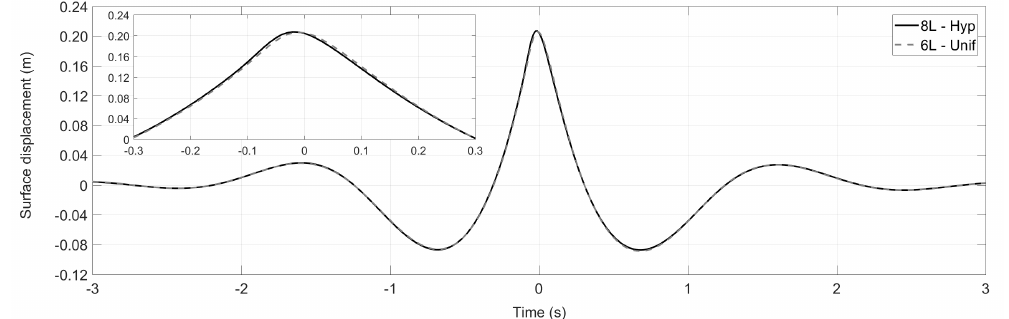
Figure 4. Convergence analysis for the NWT in